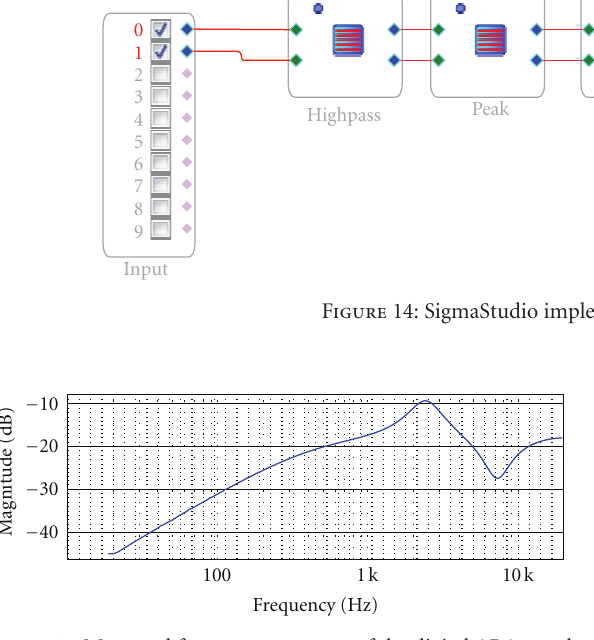
Figure 15: Measured frequency response of the digital ARA equal- izer.